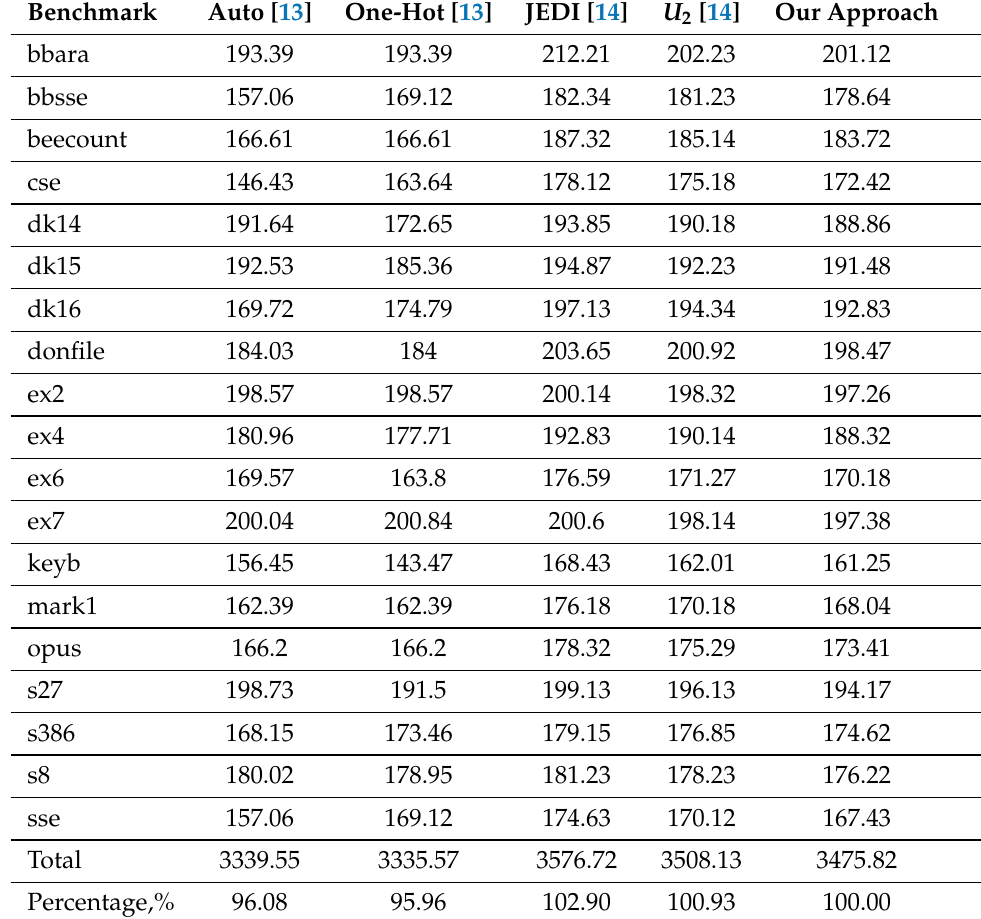
Table 14. Experimental results (the maximum operating frequency for